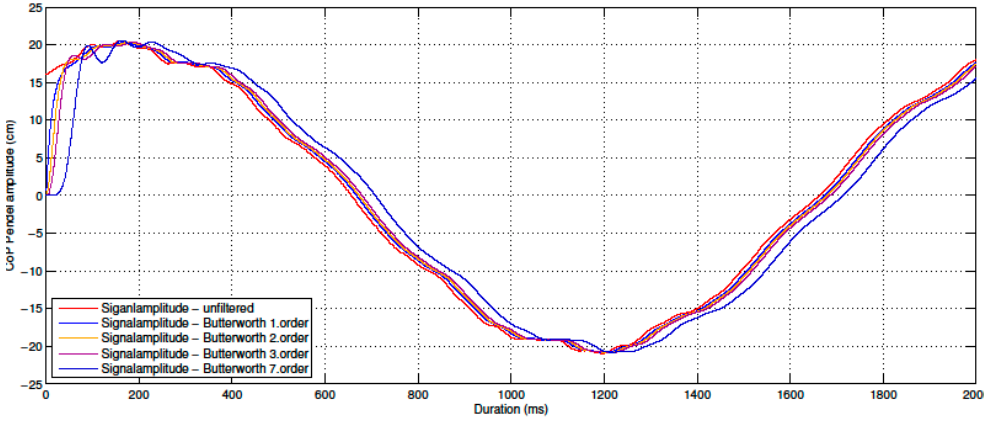
Figure 2. Paths of the X components of the CoP-track, without filter and with first- to third-order Butterworth filters.